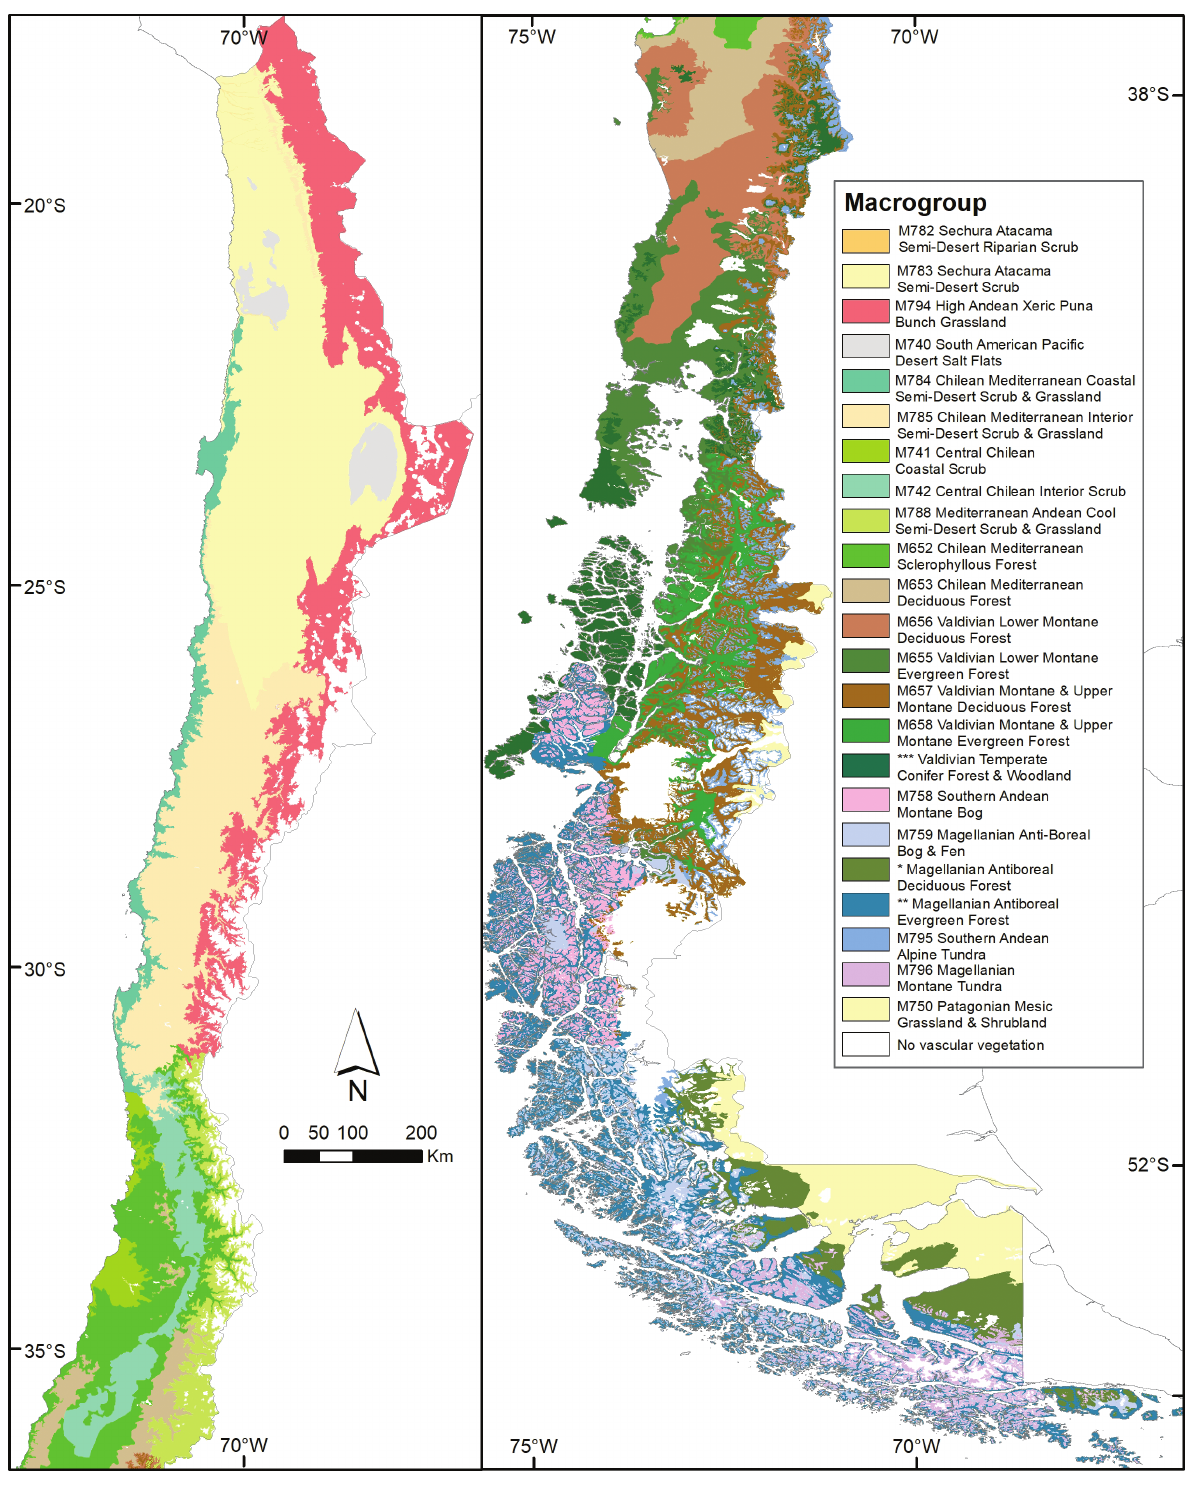
Figure 1. Map of Chilean macrogroups as a result of linkages established for the zonal vegetation units of Luebert and Pliscoff (2017). This map is available as shapefile at the Zenodo repository (http://dx.doi.org/10.5281/zeno-